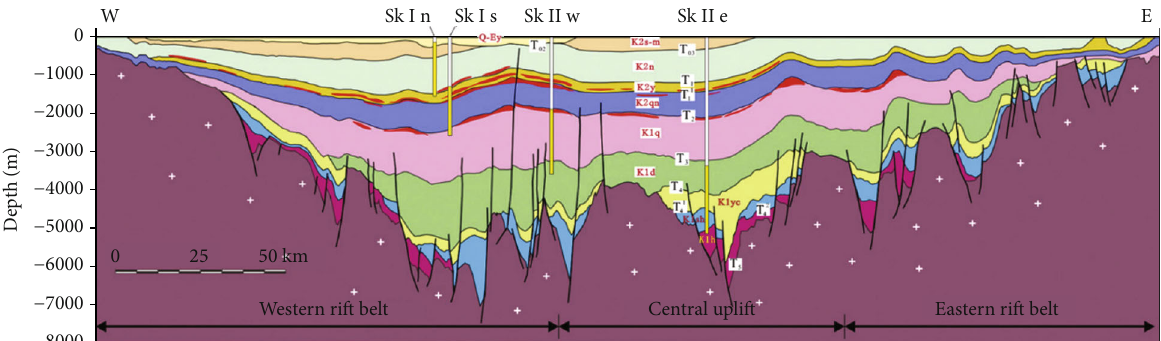
Figure 1: Location of well SK-2 and longitudinal section of Songliao Basin [7]. The yellow interval in SK-2 is the coring interval, the red strip represents the oil layer, and T02-5 represents the seismic re fl ection horizon.